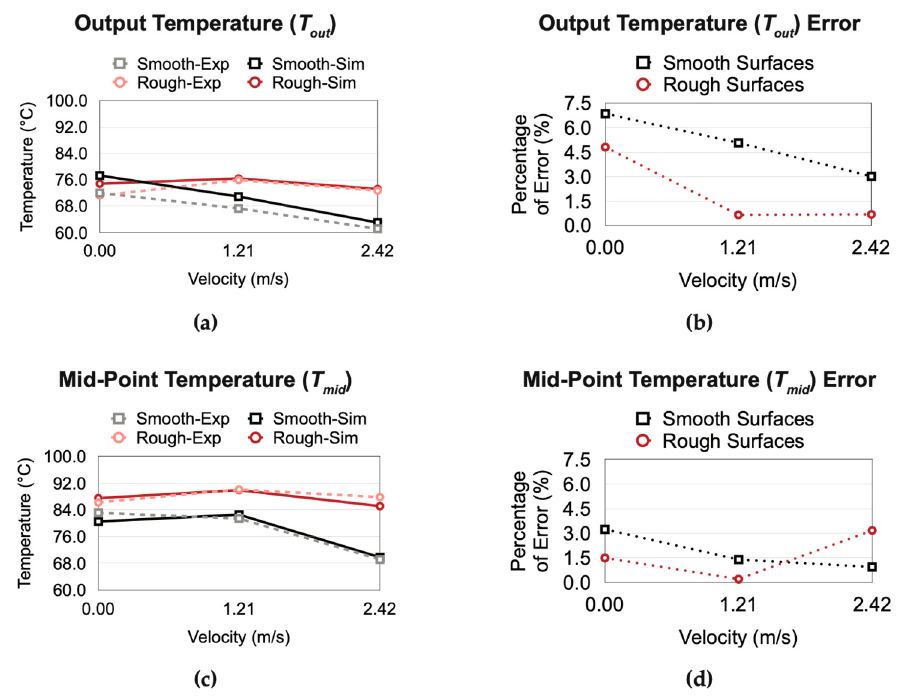
Figure 6. The temperature comparisons among the smooth and rough surfaces: ( a ) Output Temperature ( T out ); ( b ) Output Temperature ( T out ) Error; ( c ) Mid-Point Temperature ( T mid ); ( d ) Mid-Point Temperature ( T mid ) Error.